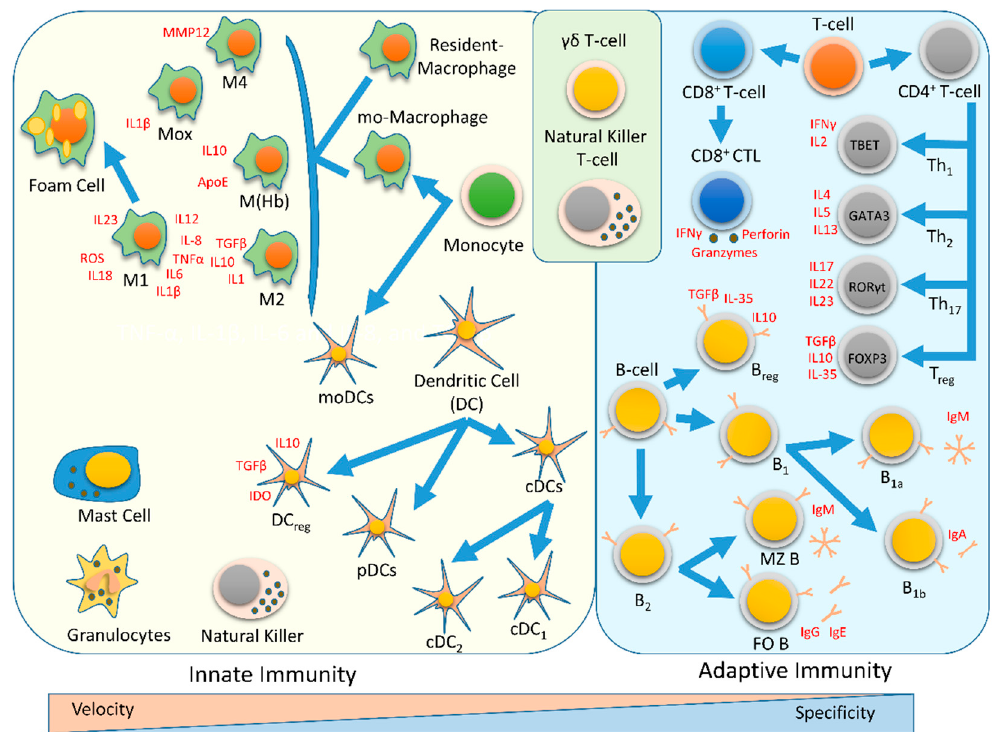
Figure 1. The innate and adaptive immune system in atherosclerosis. The immune system is divided into two main branches: innate and adaptive immunity. Innate immunity is mediated by monocytes, macrophages, dendritic cells, granulocytes, mast cells, and natural killer cells, and is characterized by the capacity of these cells to produce a rapid and nonspecific response as a first line of defense. Innate immune cells mediate host defense responses and inflammation by releasing cytokines and chemokines, activating the complement cascade and phagocytosis, and activating the adaptive immune response via antigen presentation. The adaptive immune response occurs later and depends on the presentation of antigens by antigen presenting cells (APCs) and the cytokine milieu generated by the innate response. The adaptive response is specific and relies on CD4 + and CD8 + T cell activation and antibody production by B cells. Natural killer T (NKT) cells and γδ T cells are cytotoxic T lymphocytes at the interface between innate and adaptive immunity. Abundant evidence points to a role of innate and adaptive immunity in the onset and progression of atherosclerosis. Several immune cell types play a proatherogenic role, including Th1 cells, M1 macrophages, and some B cells. In contrast, Tregs, Bregs, and DCregs have atheroprotective e ff ects. DC, dendritic cell; moDC, monocyte-derived DC; mo-Macrophage, monocyte-derived macrophage; pDC, plasmacytoid DC; cDC, conventional DC; FO B, follicular B cell; MZ B, marginal zone B cell; Breg regulatory B cell; Treg, regulatory T cell.